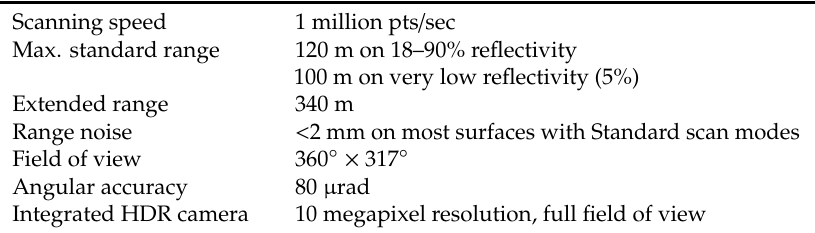
Table 1. Basic parameters of Trimble TX8 laser